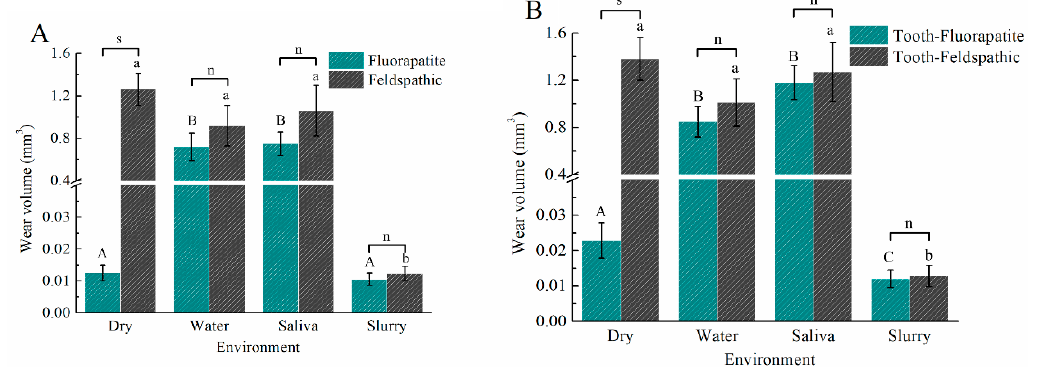
Figure 3. Wear volume of ( A ) fluorapatite and feldspathic glass-ceramics, ( B ) teeth tested with fluorapatite and feldspathic glass-ceramics. s (Significant) and n (not significant) refers to the Tukey’s HSD test results between the two types of specimens in the same environment ( α = 0.05). Same uppercase letters (fluorapatite) or lowercase (feldspathic) letters represent no significant di ff erences among values of the same type of specimens in di ff erent environments ( p > 0.05).